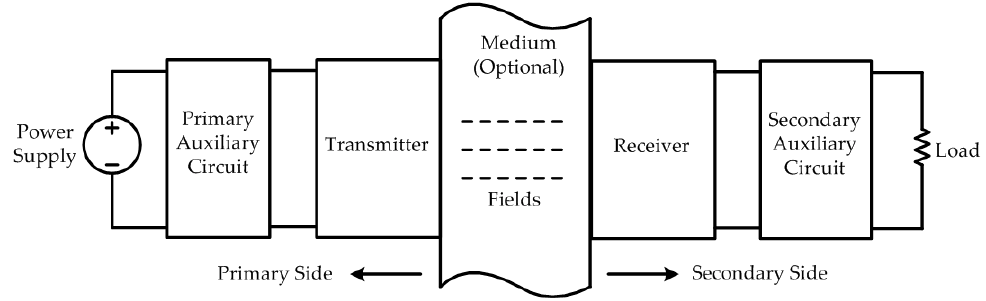
Figure 1. Typical structure of a wireless power transfer system.